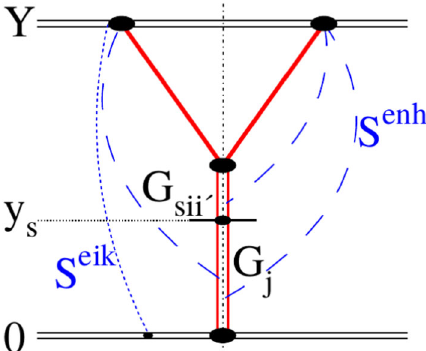
Fig. 6 The diagram for the inclusive one particle cross section for SD events. Screening effects are indicated by the (blue) short-dashed ( S eik ) and (blue) long-dashed ( S enh ) curves which describe the probability of LRG survival with respect to additional proton–proton interactions or the interactions with the intermediate partons